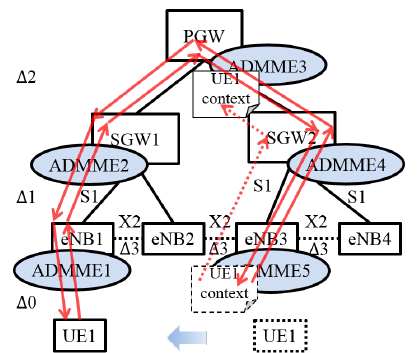
Figure 1: Conceptual architecture of distributed mobility management